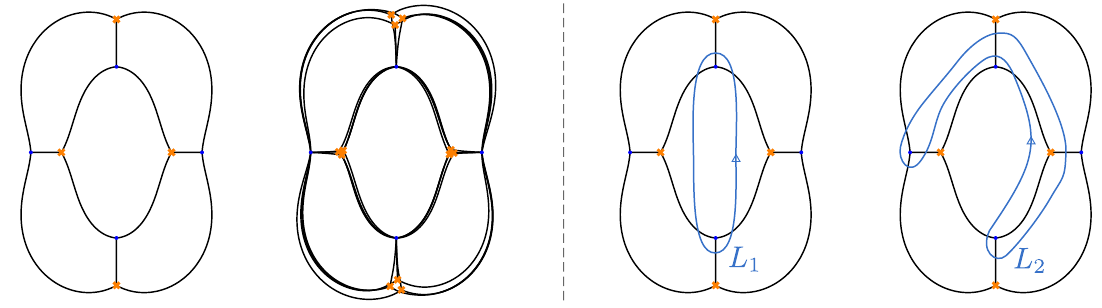
Figure 48 . Far left: a spectral network on the four-punctured sphere, made up of critical leaves associated to φ described in the main text, and φ 2 to the same φ and the small perturbation φ 2 right: two loops on the four-punctured